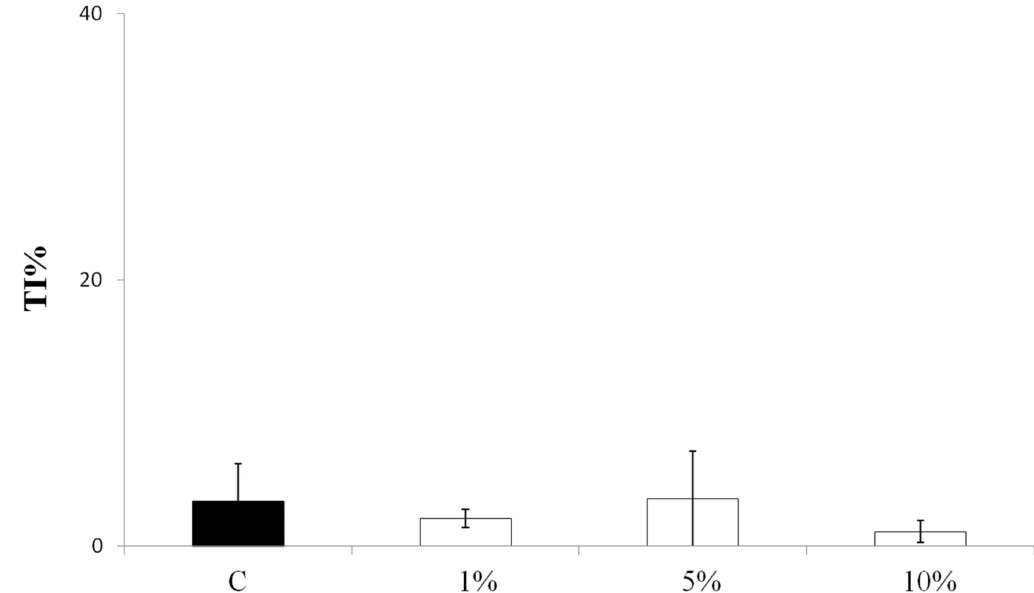
Figure 1. Genotoxic activity of spinach juice from leaves of plants grown in a normoxic condition. The activity was evaluated testing 3 different leaf juice concentrations (1%, 5%, and 10%) by Comet assay on HT29 cells after 24 h of treatment. Each histogram is the result of the mean ± SD of three determinations. TI%: tail intensity percentage. C: untreated control cells. SD: standard deviation. Spinach leaf juice has also been administrated to HT29 cells after preventive treatment with H 2 O 2 as an oxidizing agent. The juice has been tested at three different concentrations (Figure 2). Independently from the concentration, the juice shows an antioxidant activity with an evident reduction of the H 2 O 2 oxidative effect on DNA.